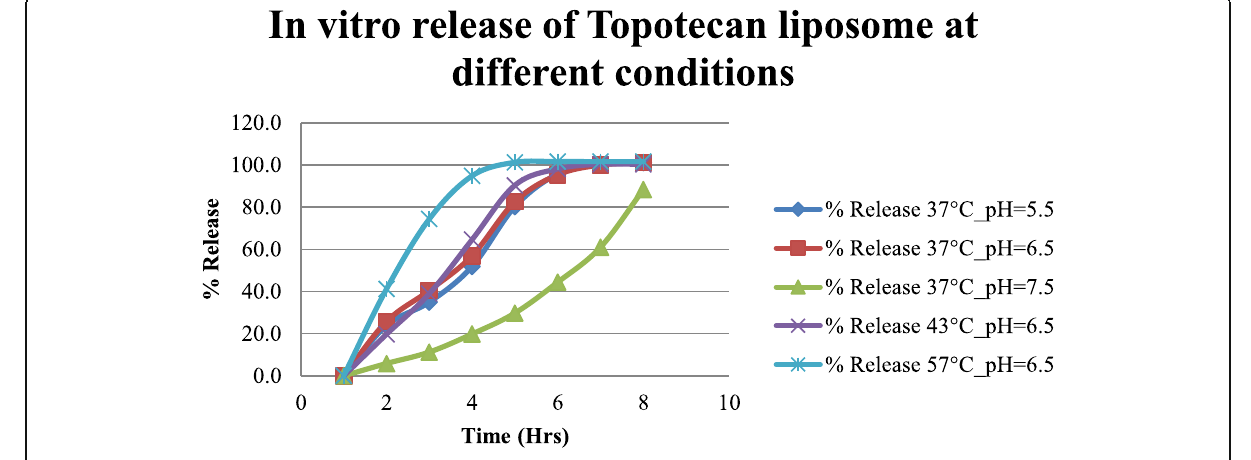
Fig. 10 Comparative data of % release of topotecan in different